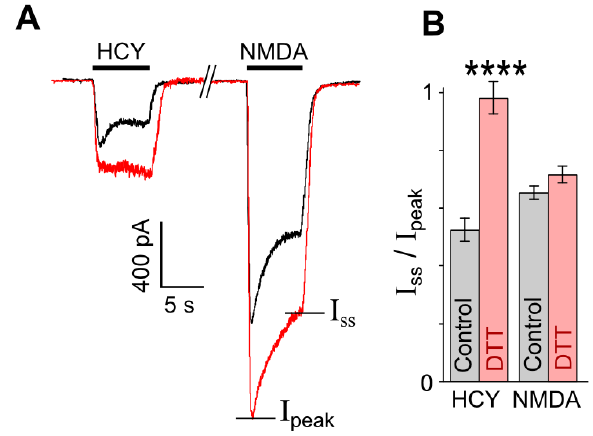
Figure 4. DTT prevents desensitization of currents elicited by HCY, but not by NMDA. ( A ) Representative traces of currents recorded at V h = − 70 mV, elicited in neurons by 200 μ M HCY and 200 μ M NMDA in control (black) and after treatment with 1 mM DTT for 90 s (red). ( B ) Mean steady-state to peak (I ss /I peak ) ratios obtained for HCY- and NMDA-elicited currents before and after treatment with DTT. **** Data are significantly different from control n = 8, p = 0.00007, Student's t -test.